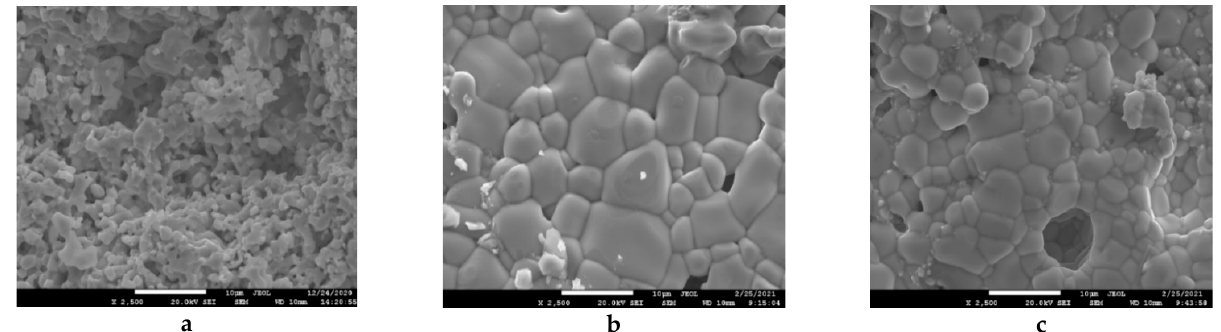
Figure 2. Scanning electron microscopy (SEM) images of the La-CMFCNO ( a ), Nd-CMFCNO ( b ) and LN-CMFCNO ( c ) ceramic samples.